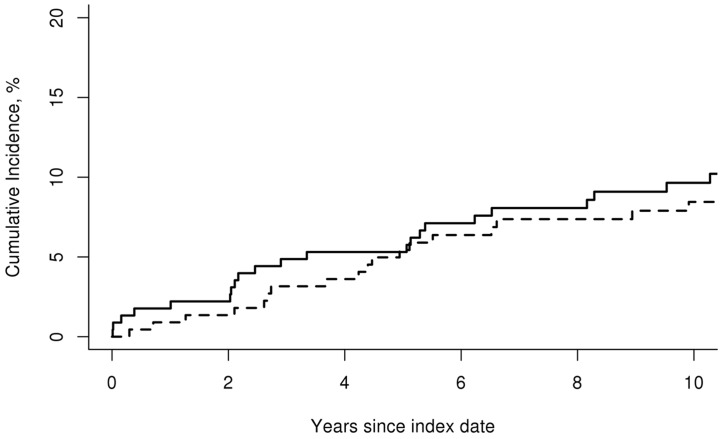
Cumulative incidence of cerebrovascular events.Cumulative incidence (%) of cerebrovascular events in 244 patients with incident GCA in the period 1950–2009 (solid line) compared to 240 subjects without GCA (dashed line).